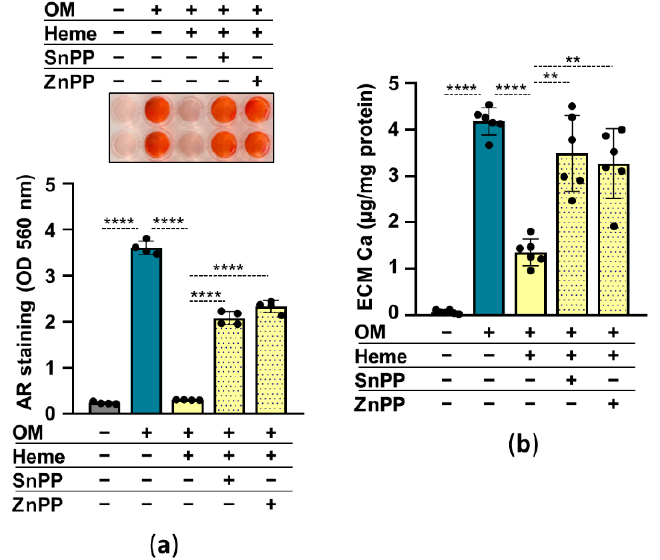
Figure 6. Inhibition of HO-1 enzyme activity diminishes the anti-calcification effect of heme. ( a , b ) Confluent HuLECs (passages 5–8) were pretreated with vehicle or SnPP (10 µ mol/L) or ZnPP (10 µ mol/L) for 3 h. After the pretreatments cells were maintained in Ctrl, OM, or OM + heme (10 µmol/L) conditions. ( a ) Representative AR staining and quantification (day5). ( b ) Ca content of the HCl-solubilized ECM is presented (day5). Data points are derived from 4 independent experiments. Data are expressed as mean ± SD. Ordinary one-way ANOVA followed by Tukey’s multiple comparison test was used to obtain p values. ** p < 0.01, **** p < 0.001.